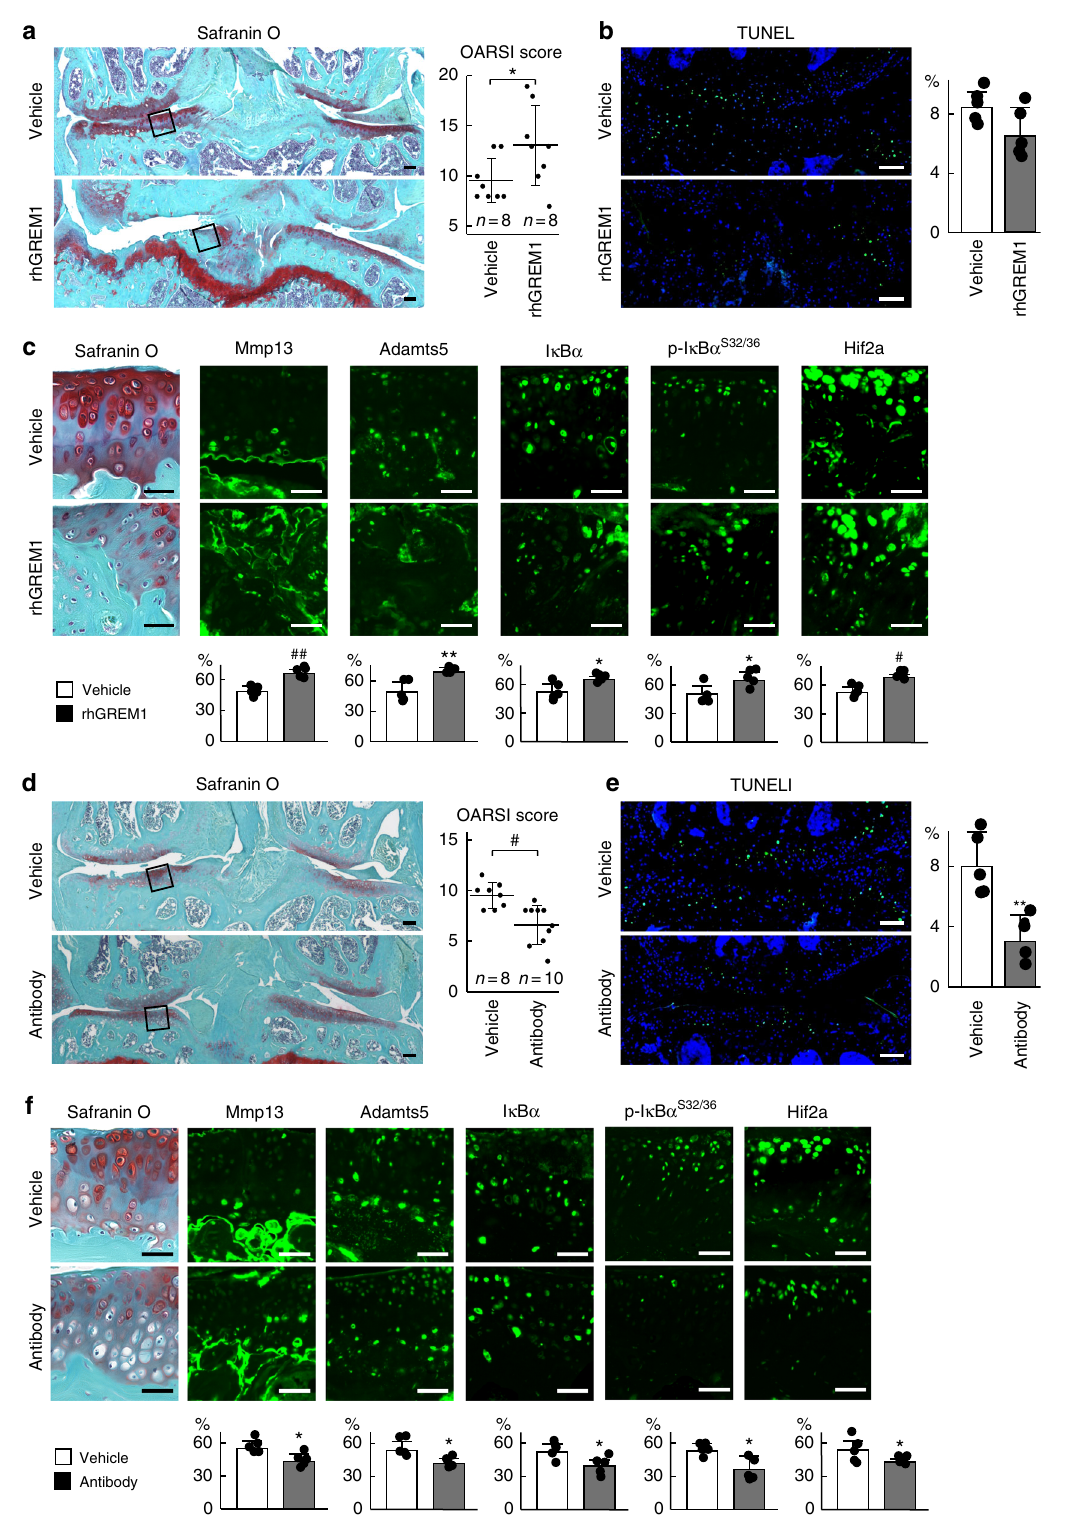
with the IKK inhibitor BMS-345541. Increased release of proteoglycans into the medium by rhGREM1 treatment was signi fi cantly inhibited by BMS-345541 to a level similar to control (Fig. 5c). Femoral heads from RelA fl / fl (RelA-Cntl) and Col2a1- Cre;RelA fl / fl (RelA-cKO) mice were also treated with rhGREM1. Release of proteoglycans was enhanced by rhGREM1 in RelA-Cntl femoral heads; however, it was not enhanced in